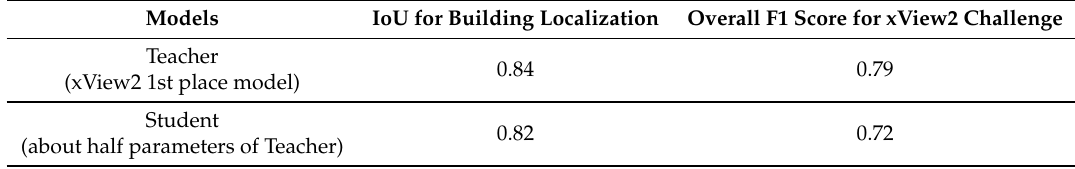
Table 4. A case study of the knowledge